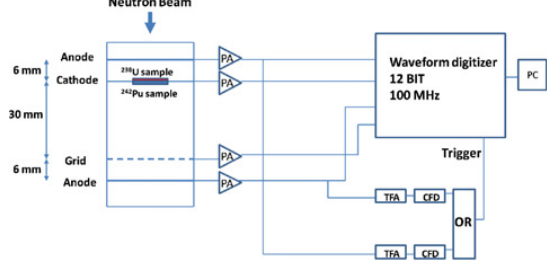
Figure 1. View on the end of the accelerator beam line(from the left) with the Ti- 3 H target for neutron production and the ionization chamber placed in front of the target end-cap.